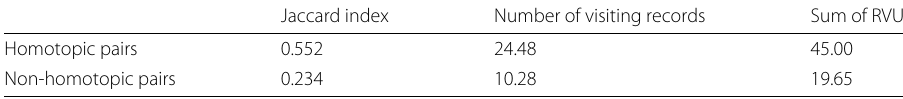
Table 5 Comparison of three edge weights in the network of information walks, between the edges connecting homotopic walks and the others connecting two non-homotopic walks Jaccard index Homotopic